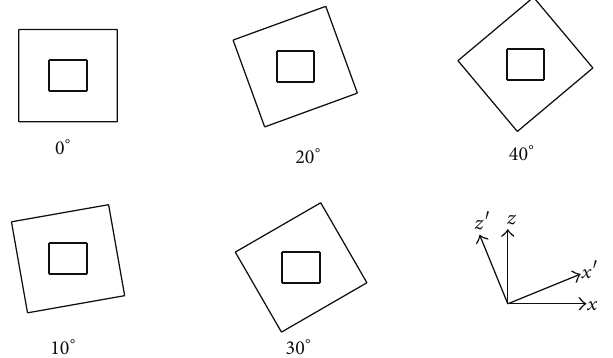
Table 2: Mechanical parameters of underground cavern in large- scale hydropower station in